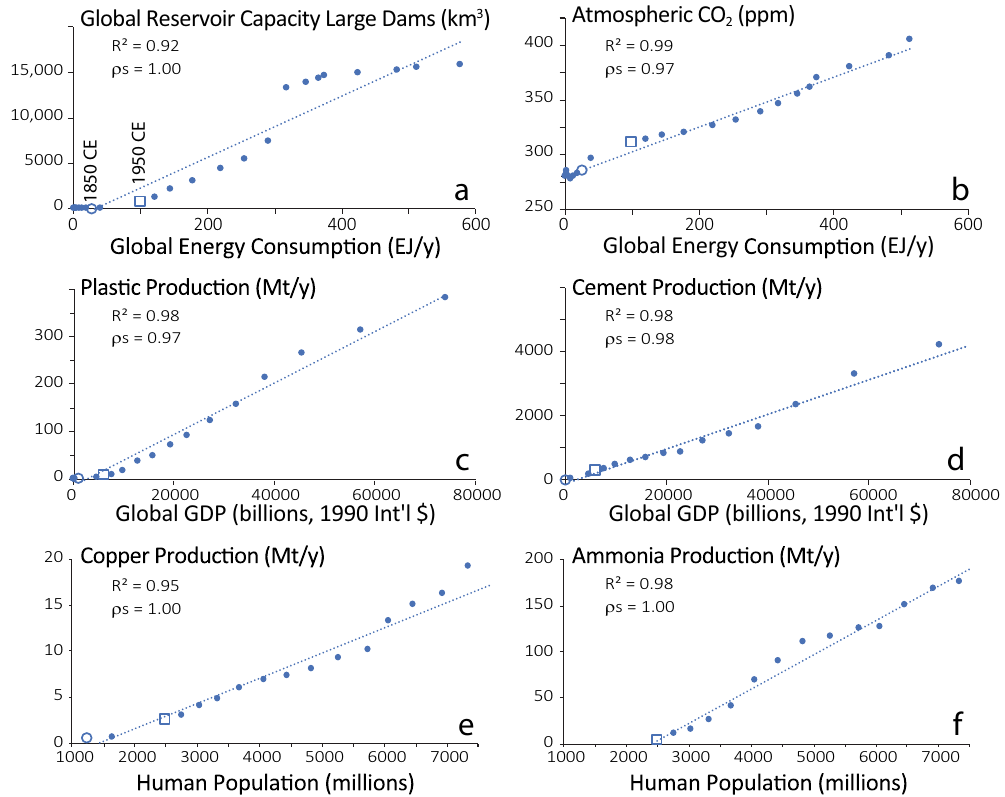
Fig. 3 Global relationships between population, productivity, and energy, the forces behind changes in the environment, and key environmental indicators. Example relationships between the global population (millions), global productivity, and global energy, the forces behind changes in the global environment, and key environmental indicators: a global reservoir capacity of large dams (km 3 ), b mixed atmospheric CO 2 (ppm), c global plastic production (Mt/y), d global cement production (Mt/y), e world copper production (Mt/y), and ( f ) world ammonia production (Mt/y) (see Supplementary-Table 2 for data, and Table 2 for other examples). 1850 CE (round) and 1950 CE (square) data points are highlighted. For data references see Supplementary Online Material. Correlation coef fi cients are provided for both dependent linear relationships (R 2 ) and Spearman ’ s Rank ( ρ s